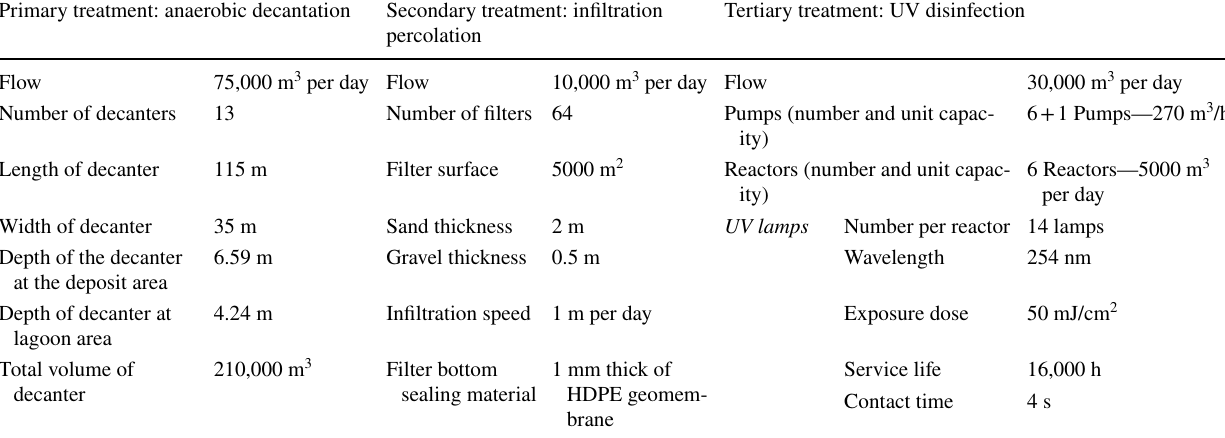
Table 1 Physical and geometrical characteristics of the wastewater treatment process of the Mzar WWTP Source : RAMSA (2002) Primary treatment: anaerobic